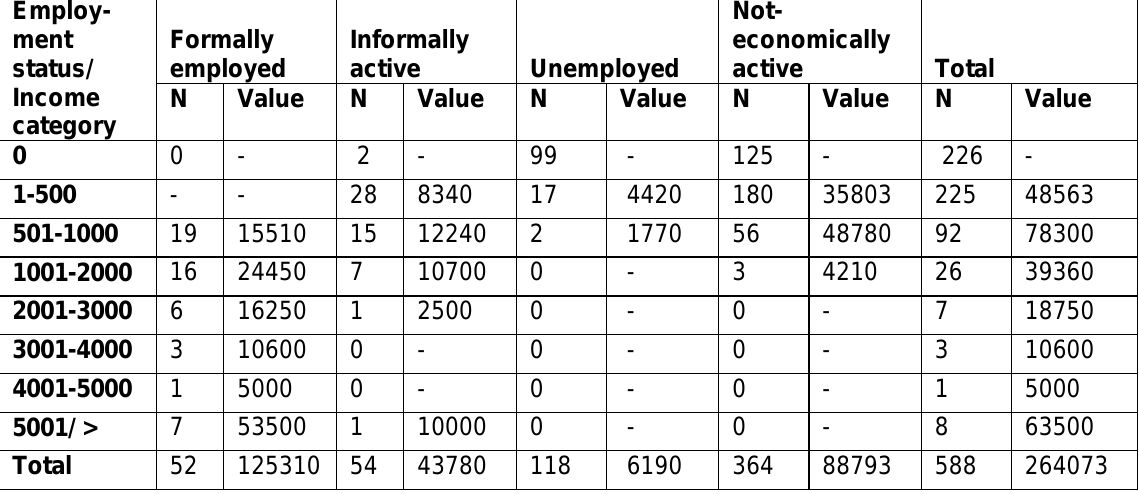
Table 5: Distribution of income by employment status in 2007